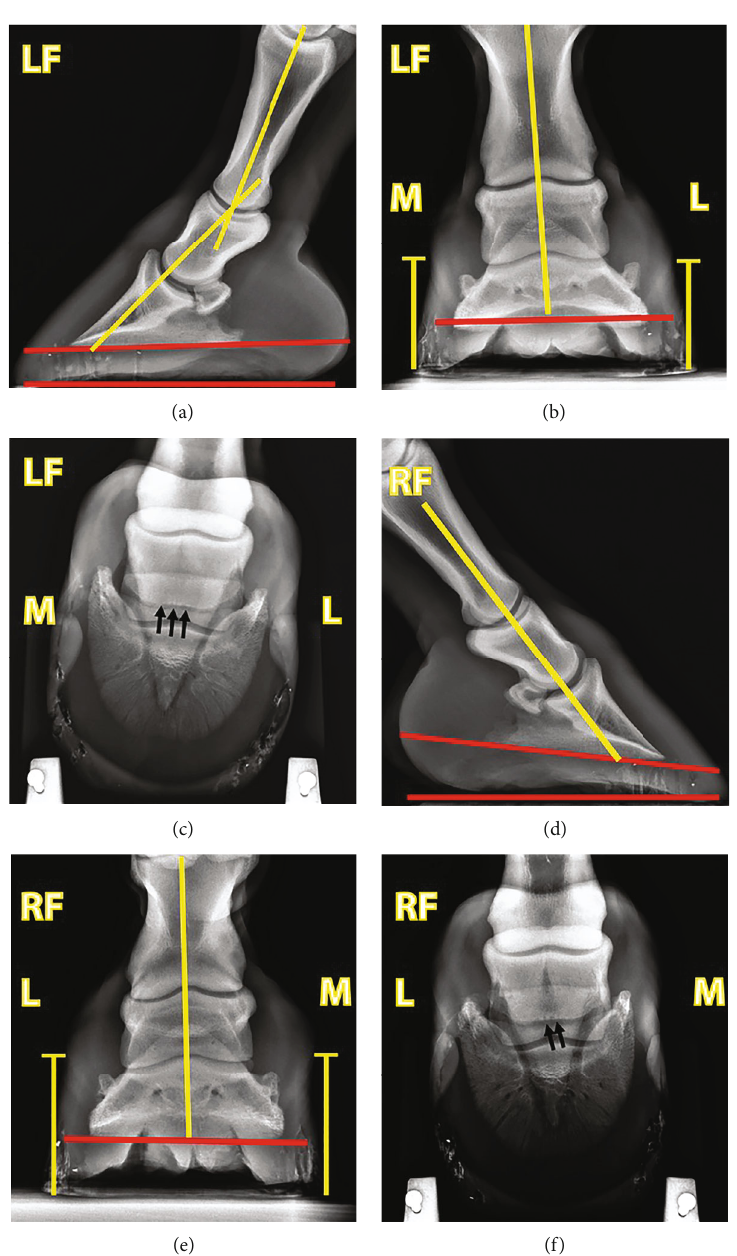
Figure 2: Radiographic images of the (a – c) left and (d – f) right front hooves of a show jumping pony. Both front hooves demonstrated a positive hoof angle, denoted by the angle between red lines at the ventral aspect of the co ffi n bone and ground contact surface (a, d), with a greater degree in the right front hoof (d). The left front hoof also showed a negative hoof-pastern axis (a). The hoof wall height between the medial and lateral sides of each hoof was equal, indicating no shear heels were observed in both front hooves (b, e). A slight irregularity of the navicular bone ’ s ventral border was concomitantly detected in both front hooves (c,